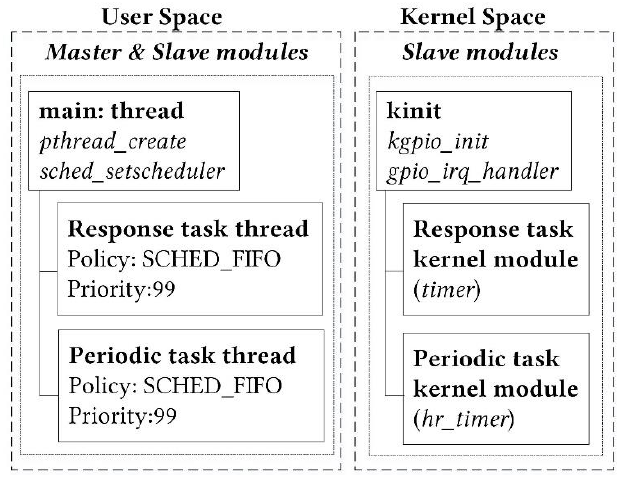
Figure 3. Measurement modules real-time design infrastructure.